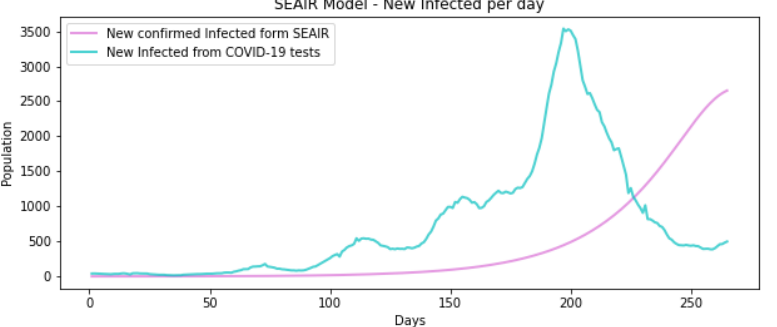
Figure 16. Comparison of cumulative infected people between SEAIR model and COVID-19 tests in Denmark’s second wave after applying the best vaccination plan